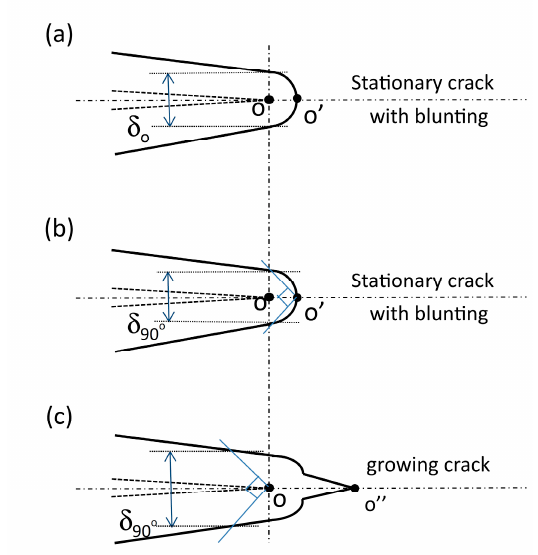
Figure 1. Three typical CTOD definitions: ( a ) CTOD defined at the original crack tip, ( b ) CTOD defined by the 90° intercept approach at the actual, blunted crack tip and ( c ) CTOD defined by the 90° intercept approach at the original crack tip of a growing crack